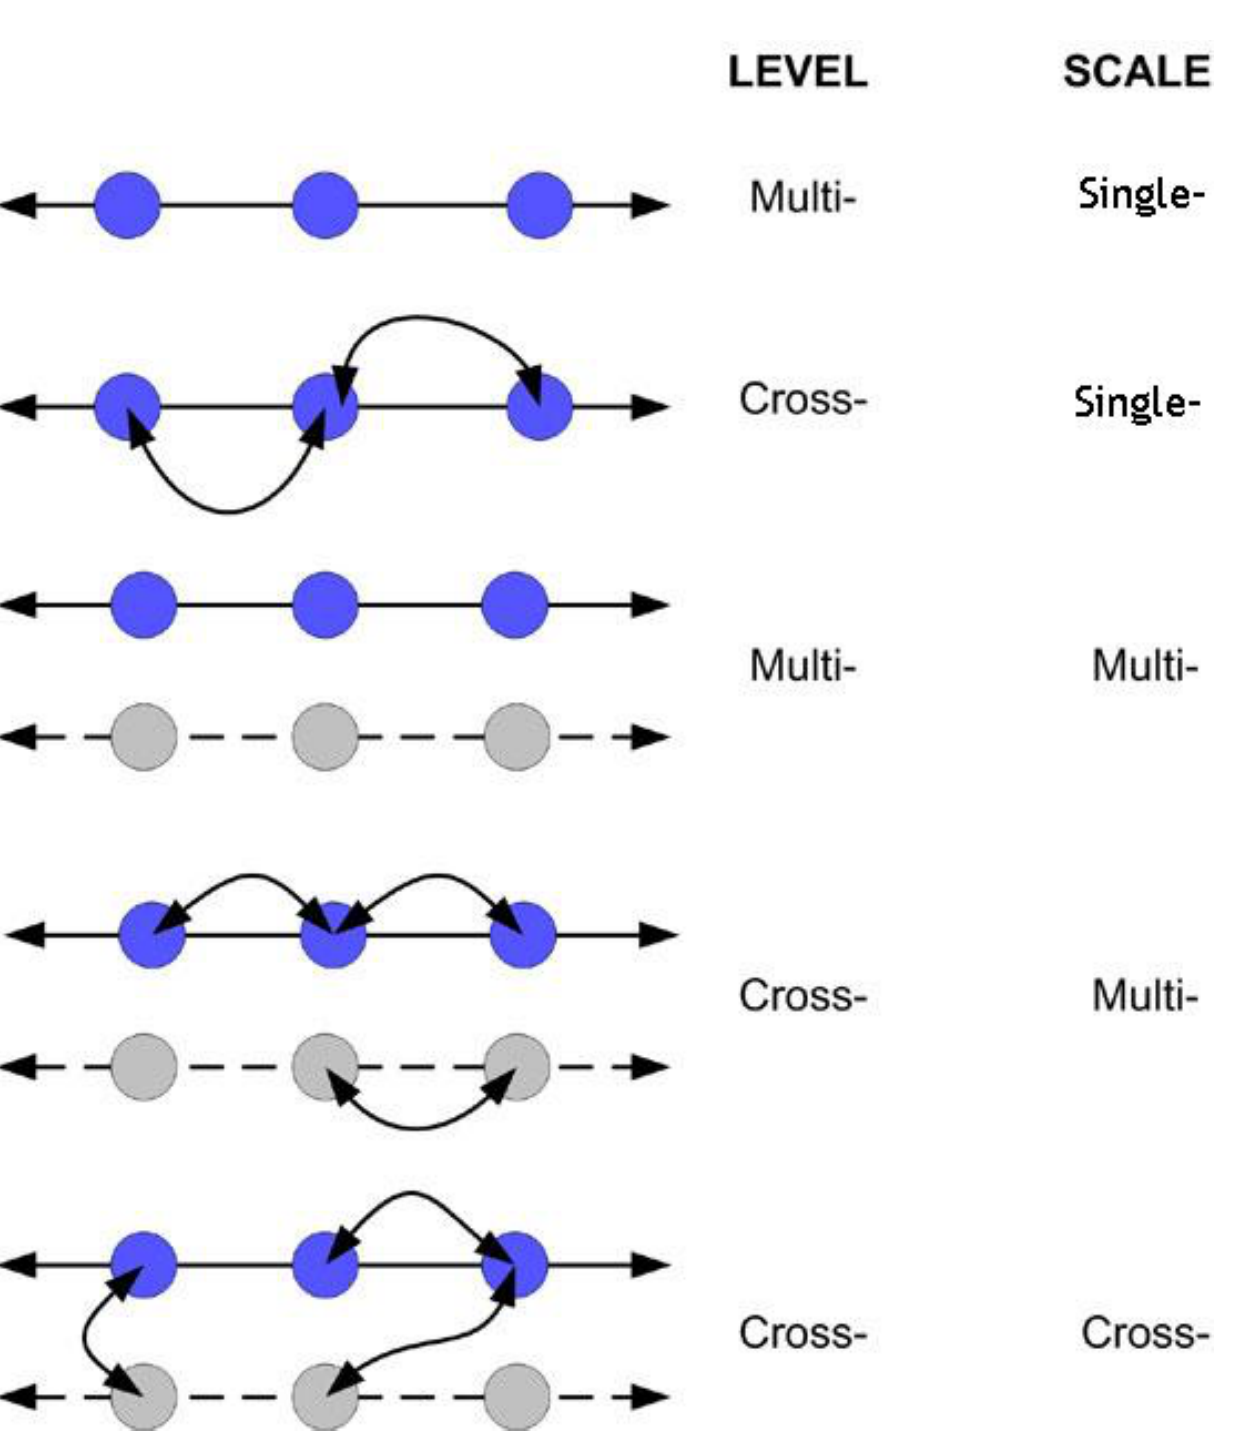
Fig. 2 . Schematic illustrations of cross-level, cross-scale, multilevel and multiscale